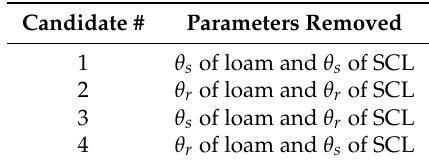
Table 2. Observable systems and their removed